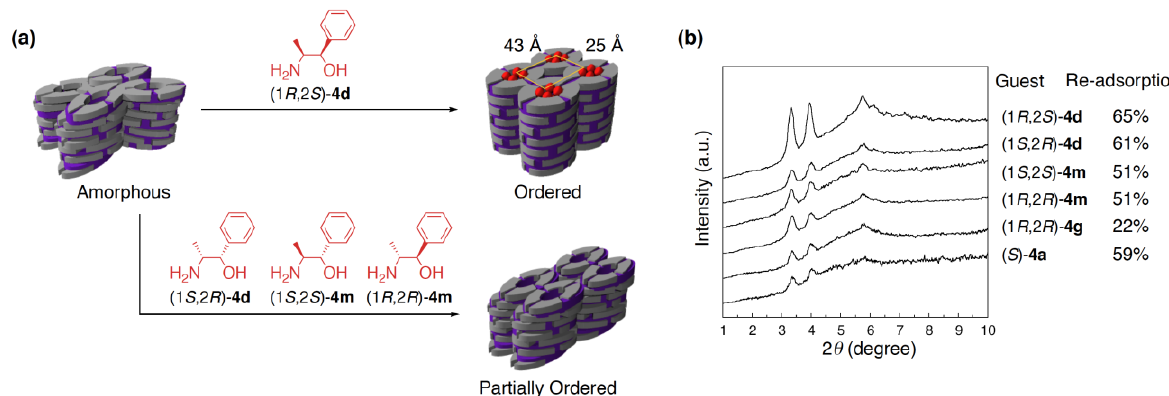
Figure 8. Guest-selective structural switching of the cross-linked polymer: ( a ) Schematic representation; and ( b ) XRD profiles of the cross-linked polymers obtained by the reconstitution of the apo-polymer with various amino